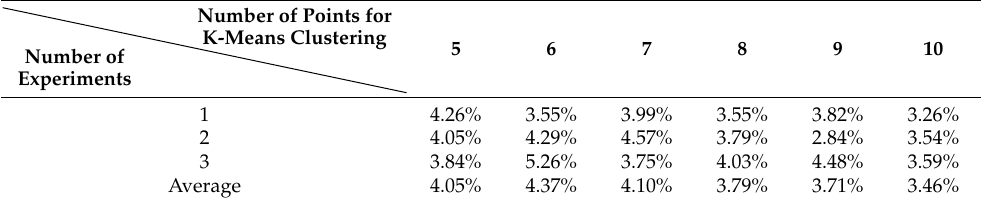
Table 2. Percentage of narrow triangles after unstructured grid optimization in small area of sea.